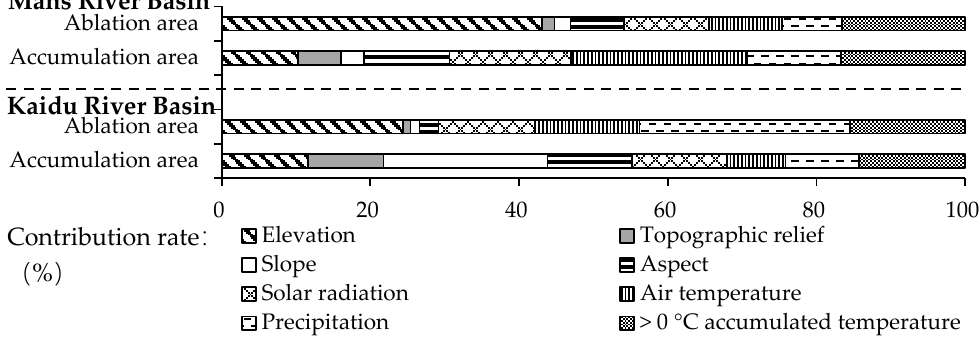
Figure 8. The contribution rate of each factor in the accumulation/ablation area in both basins. In the accumulation area, the Manas river basin’s positive mass balance and topo- graphic complexity are higher than the Kaidu river basin (Table 4). It is worth noting that the slope factor has a very high explanatory power (22.06%) in the accumulation area of gentle slopes [55,56]. The accumulation area in the Manas river basin has the highest con- tribution rate of air temperature (23.73%). Taking into account factors such as more glaci- ers and larger scales in the Manas river basin, and then comparing climate data such as temperature and precipitation, it can be inferred that the stability of glaciers in the Manas river basin in the accumulation zone is higher and the surrounding environmental condi- tions are more conducive to the formation of positive mass balance of glaciers than those in Kaidu river basin. In the ablation area, the difference between both basins in the statis- tics value of the factors is slight. Still, the negative mass balance value of the Manas river basin is higher. The highest contribution rate of precipitation factor in the Kaidu river basin (28.33%) was slightly higher than that of elevation. The highest contribution rate of elevation factor in the Manas river basin (43.05 %). Glacier ablation is partly due to sea-